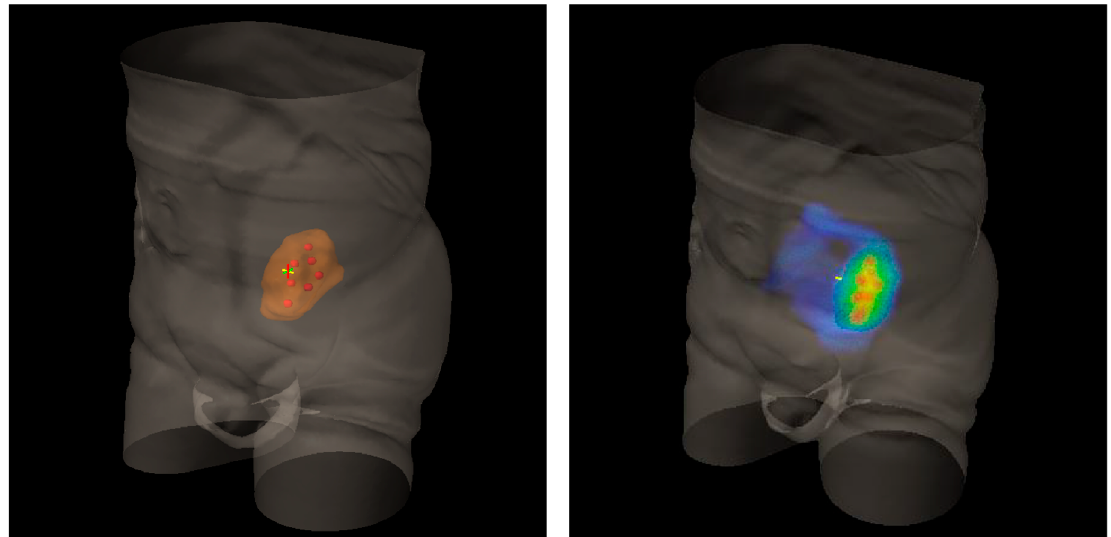
Figure 2. Three-Dimensional (3D) rendering of bulky metastatic iliac lymph node packets from urothelial bladder cancer in a patient candidate for a salvage pelvic radiotherapy (on the left ). On the right , 3D dose distribution with a lattice simulation approach. Blue is for the conventional standard dose, red for high peak ones.